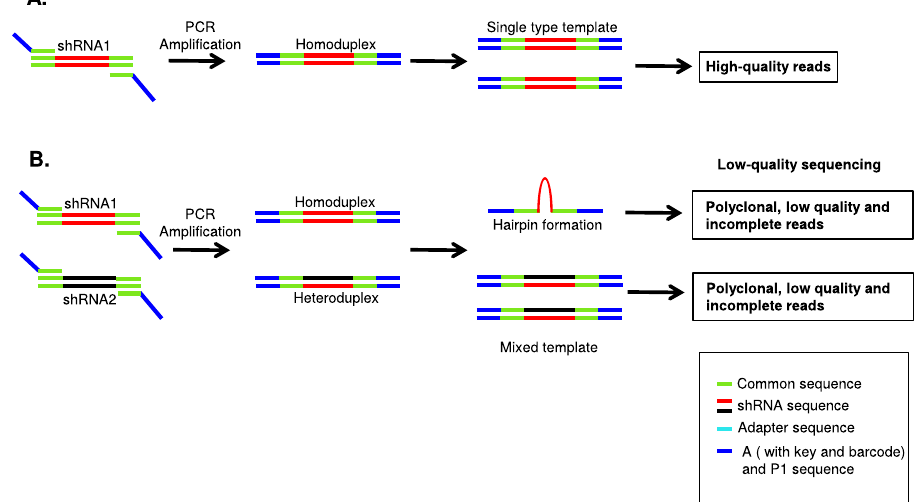
Figure 1. Schematic depicting challenges with shRNA library sequencing. ( A ) Schematic showing expected PCR product when amplifying a mixed-oligo library. ( B ) Schematic showing the formation of secondary structures (hairpin structure) and heteroduplex formation (mixed template due to primer shortage during high number PCR cycles), resulting in low quality sequencing